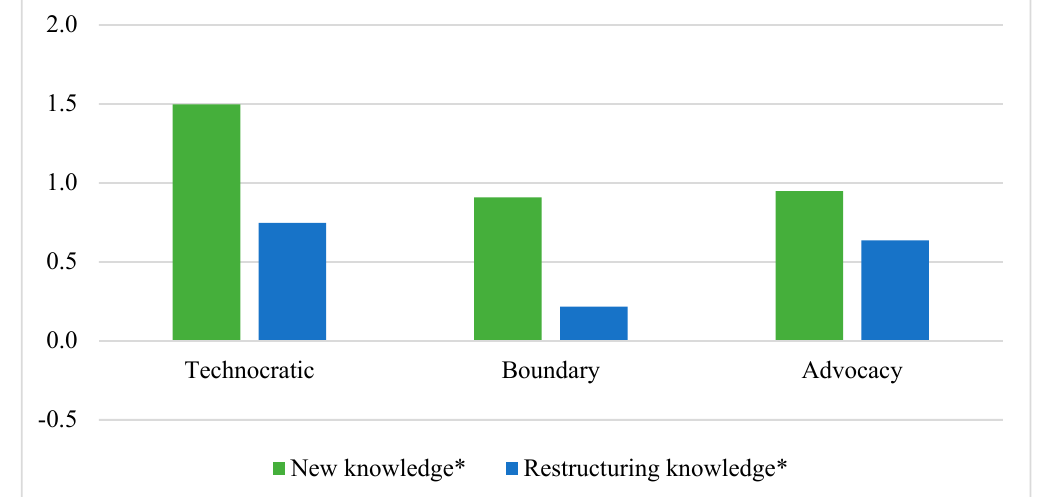
Figure 2. Comparing mean scores between ideal types, for both cognitive learning variables ( n = 18). High ≥ 1; medium = 0.5–1; low = 0–0.49; and none ≤ 0. The asterisk (*) denotes that for this variable, there were statistically significant differences in scores between the cases, as revealed by the Kruskal-Wallis test.